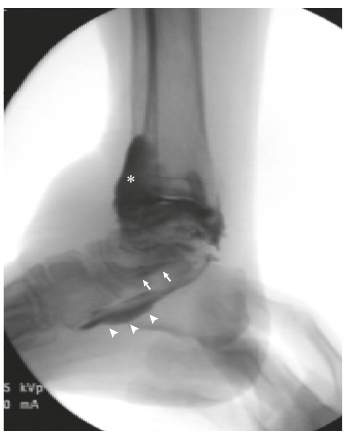
Figure 4: Arthrogram of the right ankle. Constant medium leaked anteriorly into the syndesmosis and the tendon sheath of the extensor digitorum longus (asterisk). Leakage may also be seen in the tendon sheaths of the tibialis posterior (arrow) and the flexor hallucis longus (arrowhead).